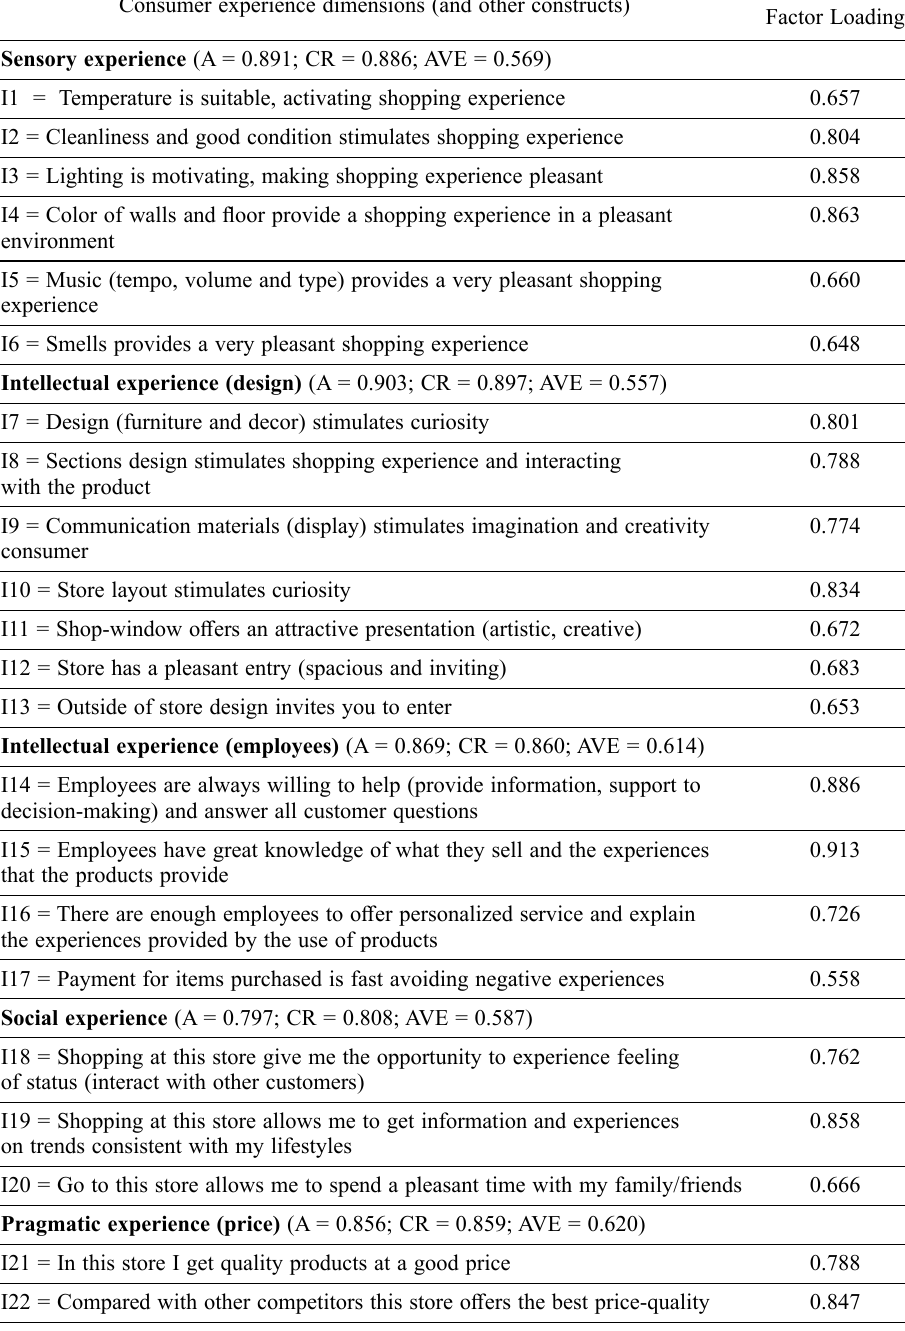
Table 2. Measurement model (reliability and